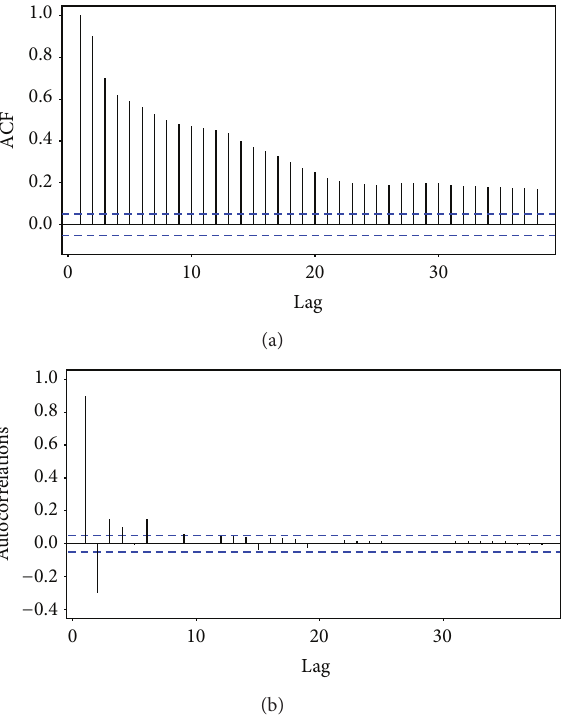
Figure 4: Autocorrelation function variable SO 2 (a) and residual partial correlation (b).